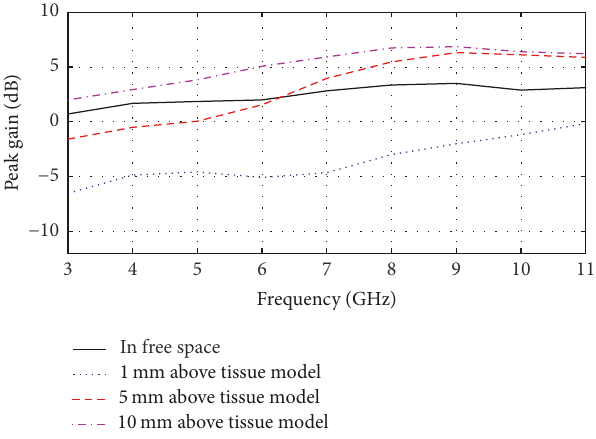
Figure 16: Peak gain of the proposed PM antenna.